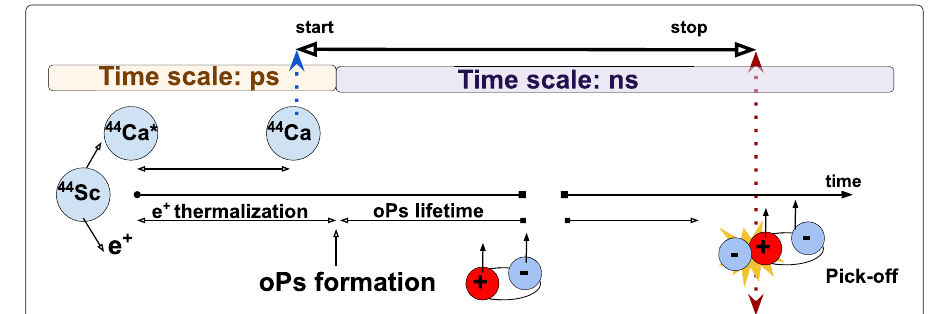
Fig. 2 Scheme of the time sequence in the processes used for positronium imaging. A 44 Sc nucleus undergoes β + decay. Next, on the average after about 3 ps, excited 44 Ca ∗ emits prompt gamma with energy of 1160 keV (dotted blue arrow). Parallelly, positron travels through matter, thermalizes, and forms an ortho-posironium bound state. Interaction with surrounding molecules or conversion process leads to emission of two photons. The mean ortho-positronium lifetime is in the order of nanoseconds, in contrast